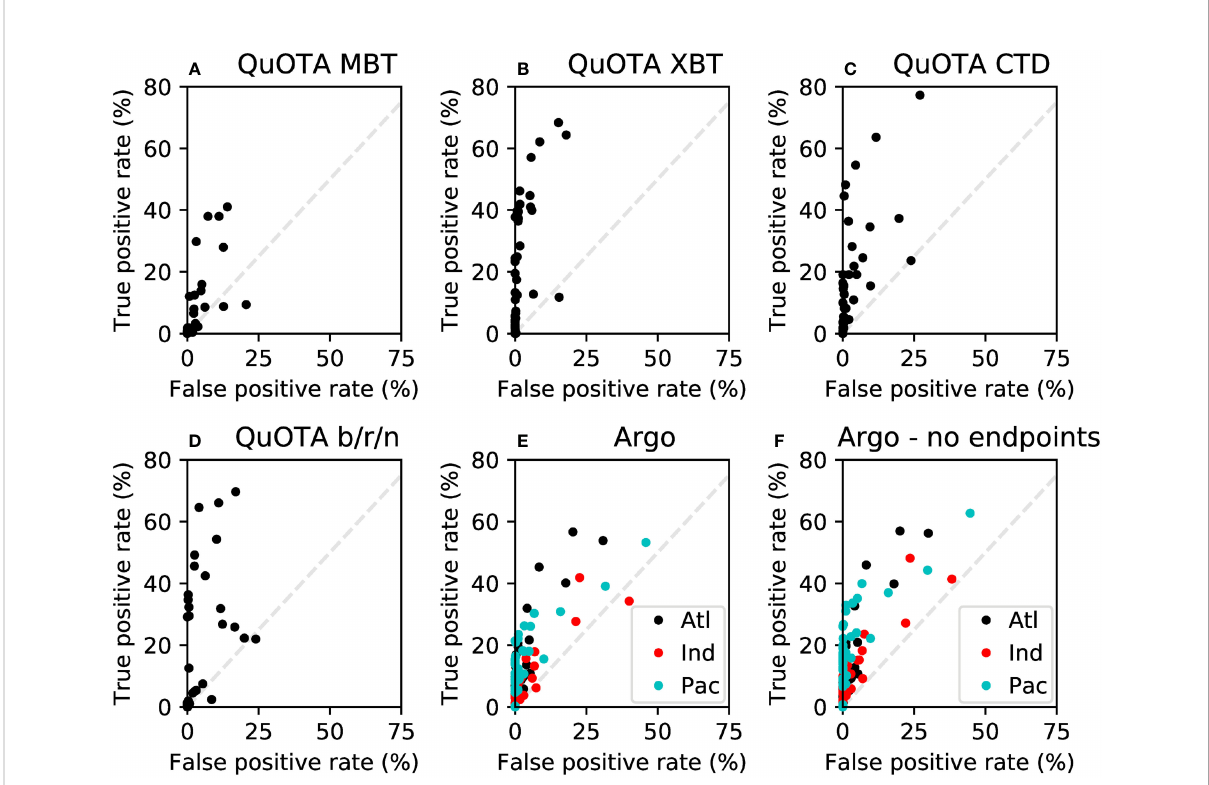
FIGURE 4 (A) The performance of each individual QC check on QuOTA MBT data; (B – D) as (A) except for QuOTA XBTs, CTDs and bottles/rosettes/nets respectively; (E) as (A) except for Argo pro fi les in 2010 for the Atlantic Ocean (Atl; blank circles), the Indian Ocean (Ind; red circles) and the Paci fi c Ocean (Pac; cyan circles); (F) as (E) but with the last pro fi le point of each Argo pro fi le removed. Grey dashes: the lines of equal TPR and